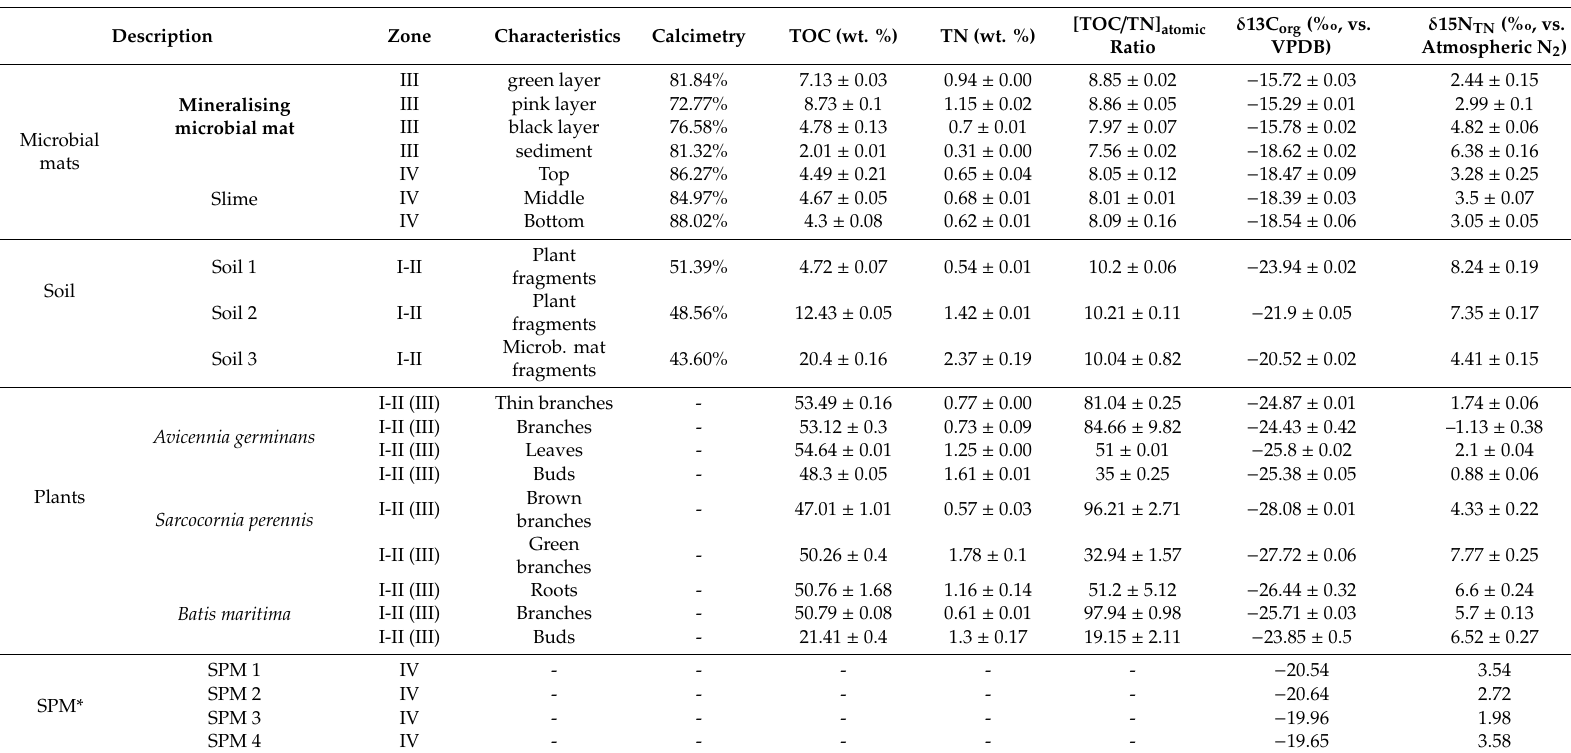
Table 1. Elemental (TOC, TN and [C / N] atomic ratio) and isotopic ( δ 13 C org and δ 15 N TN ) signatures of the di ff erent potential organic matter sources that were identified in the area of the lagoon. All analyses were performed on the 0–2000 µ m fraction in triplicate, except for the suspended particulate matter, where the amount of material was not su ffi